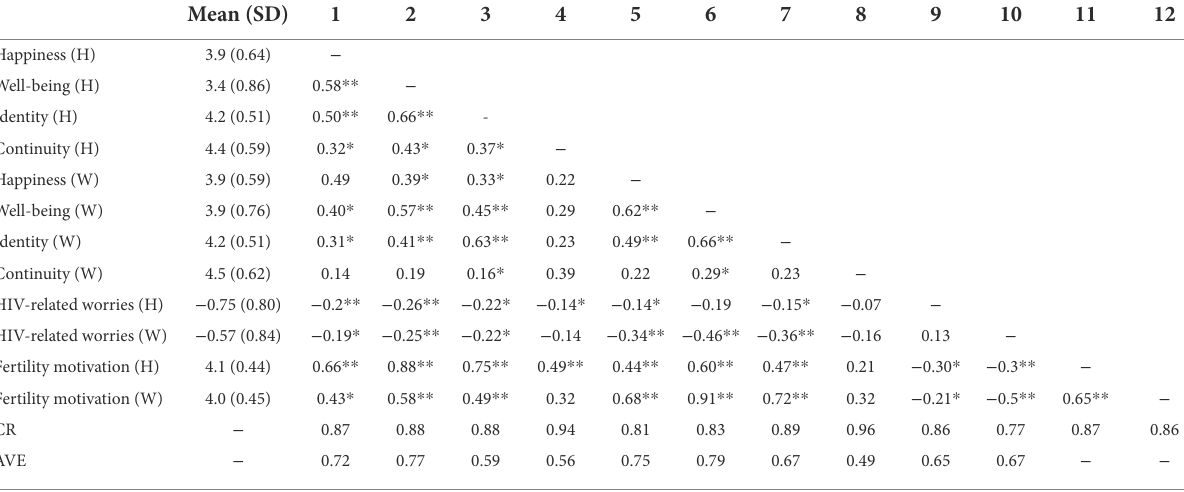
TABLE 2 Descriptive statistics and bivariate correlation in husband-wife dyads.